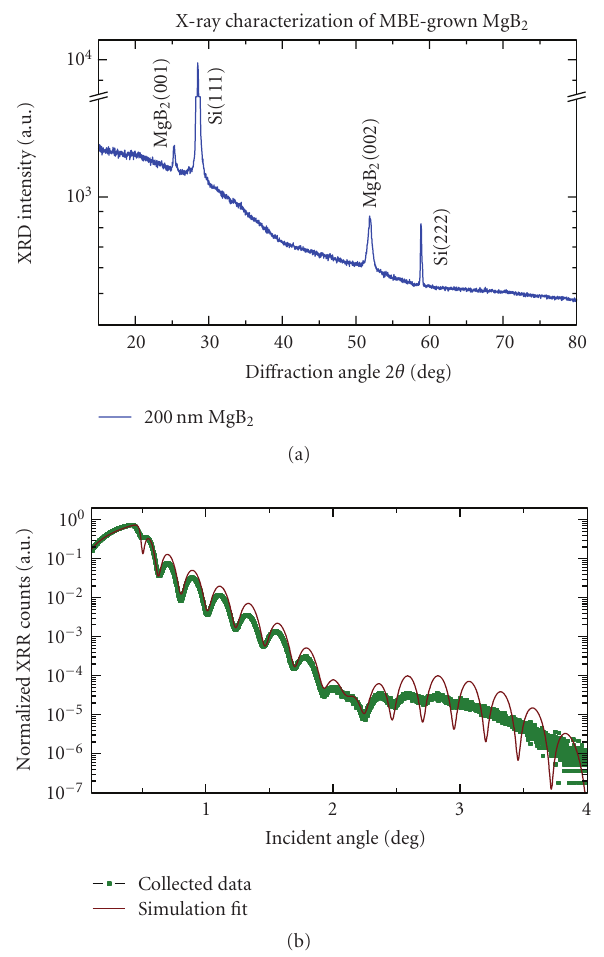
Figure 4: X-ray characterization of MBE-grown MgB 2 : (a) X-ray di ff raction of a 200 nm film, showing only the MgB 2 ( 00l ) di ff raction peaks in addition to substrate peaks; (b) Reflectivity scan of a MgB 2 thin film. The film thickness and roughness amplitude are extracted from the simulation fit to the data.